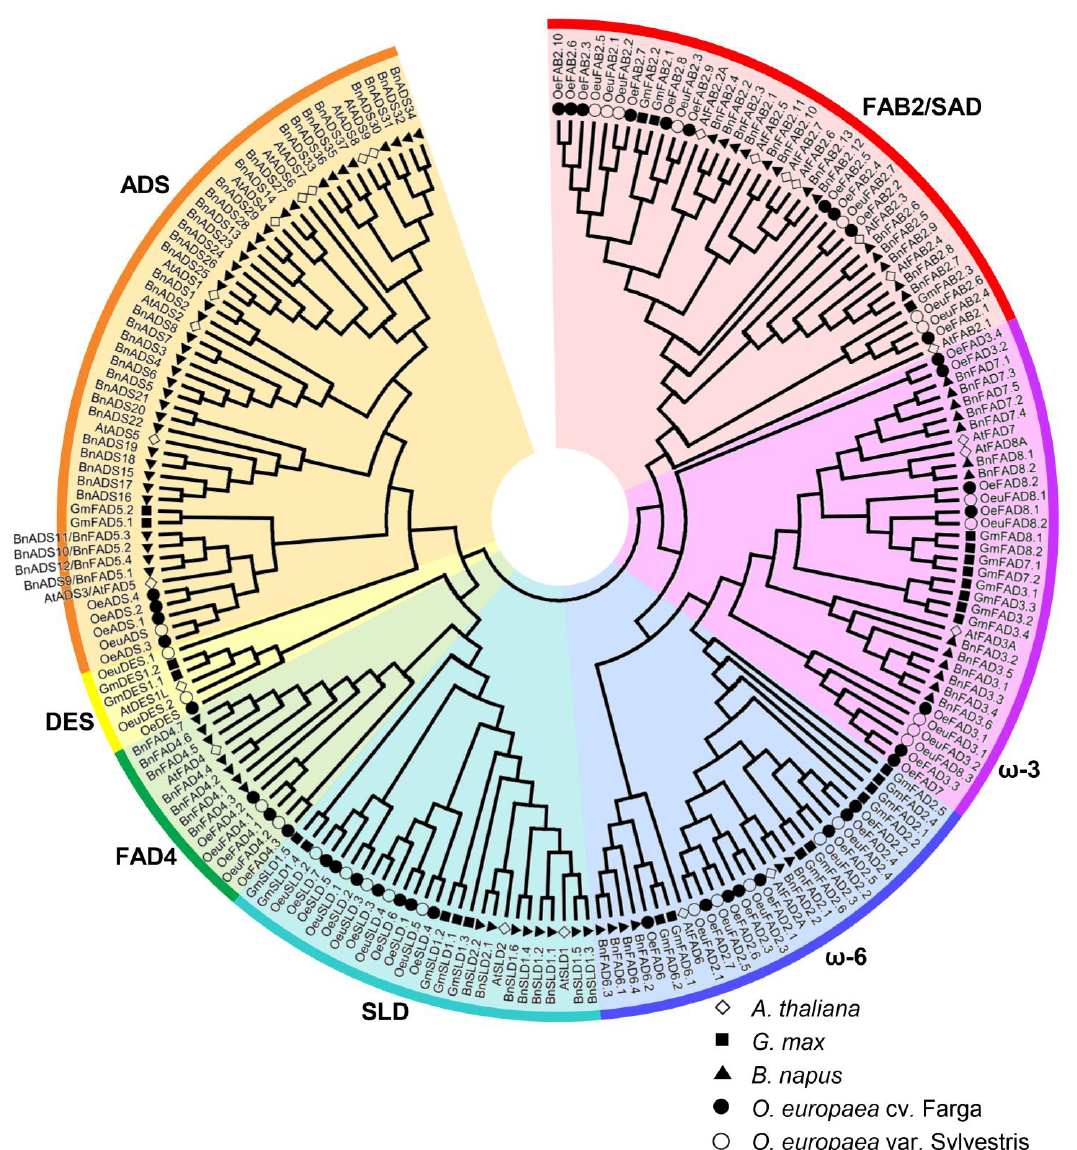
Figure 1. Phytogenetic tree of FAD genes in A. thaliana , G. max , B. napus , O. europaea cv. Farga and O. europaea var. Sylvestris. FAD genes in different species were shown by different icon shape. The gene IDs of FAD sequences in A. thaliana , G. max and B. napus referred from The Arabidopsis Information Resource [ 12 ], Chi et al. [ 13 ] and Xue et al. [ 14 ], respectively. The different groups were represented by differently colored bands.